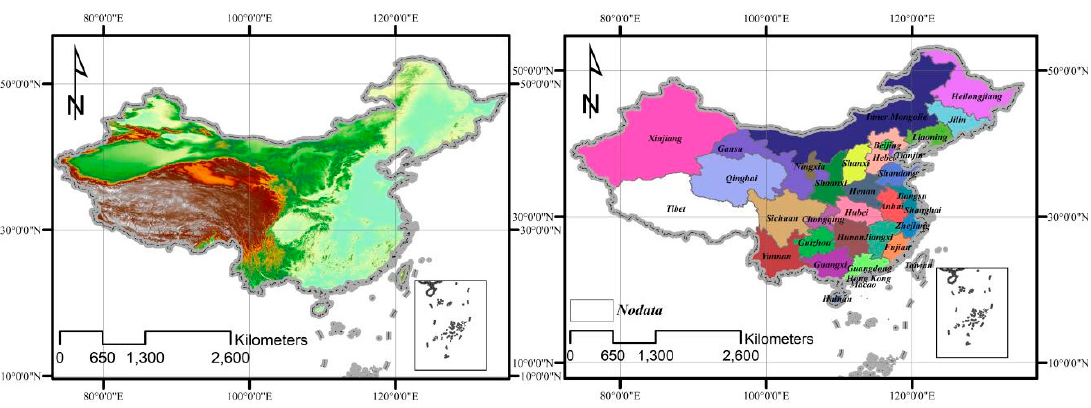
Figure 1. The location of the study area.